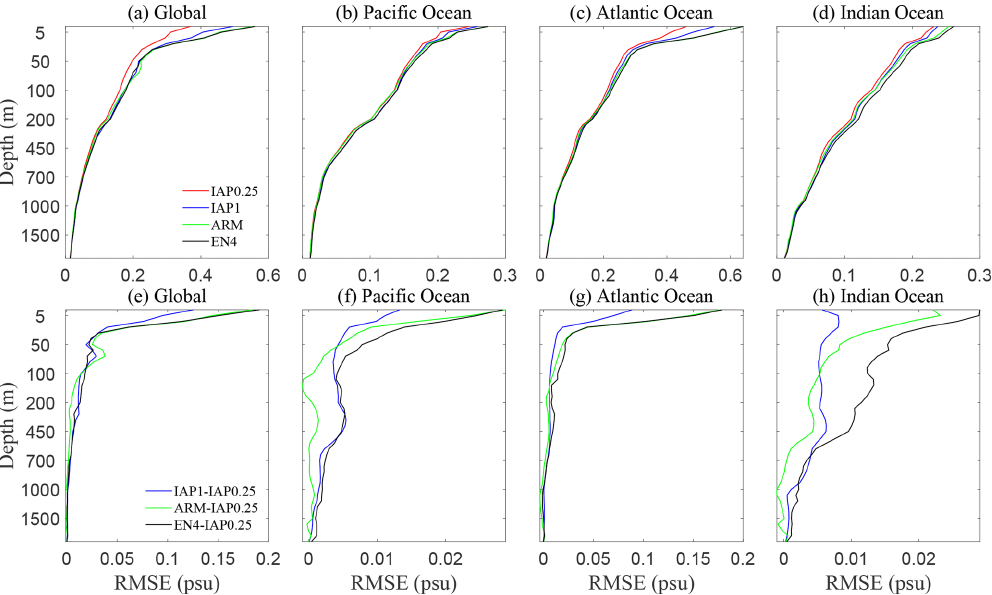
Figure 9. (a–d) Vertical distribution of RMSE for IAP1 ◦ , ARMOR3D, EN4, and IAP0.25 ◦ for the globe and three major basin regions during 1993–2018. (e–h) Vertical distribution of RMSE for IAP1 ◦ , ARMOR3D, and EN4 minus IAP0.25 ◦ , respectively.